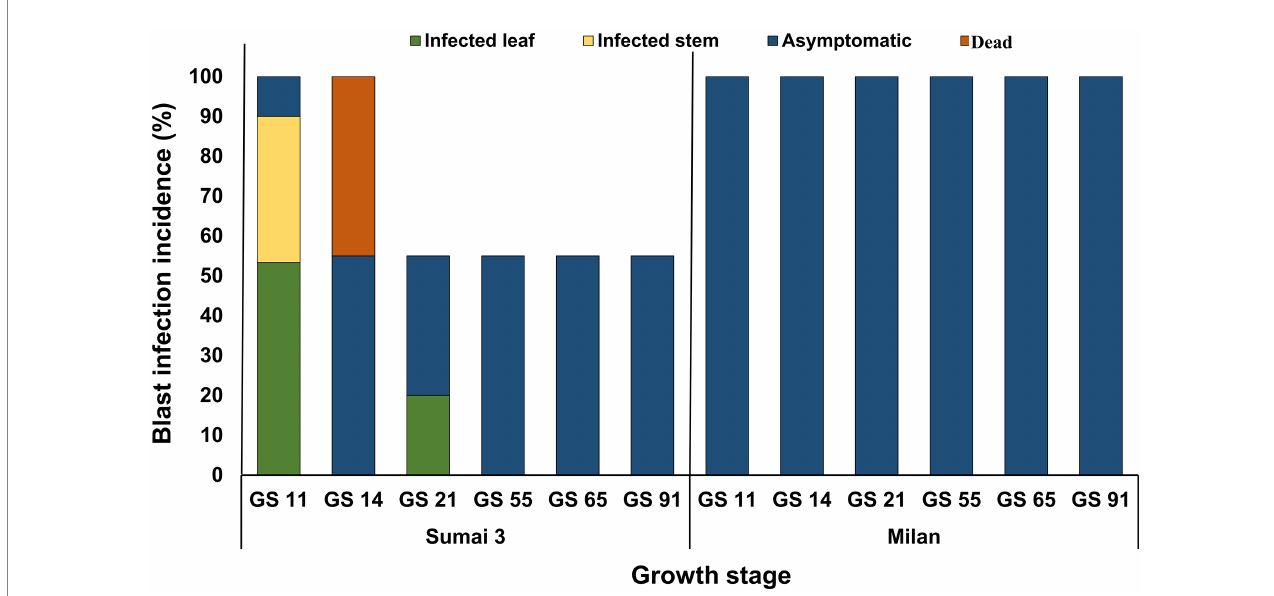
FIGURE 7 MoT infection incidence (%) in wheat plants grown from MoT infected seeds of Sumai 3 and Milan in the climate chamber. Sampling was performed at GS 11 (first leaf emerged), GS 14 (emergence of the 4th leaves), GS 21 (main stem with one tiller), GS 55 (half of the ear emerged above flag leaf ligule), GS 65 (mid flowering), and GS 91 (grain